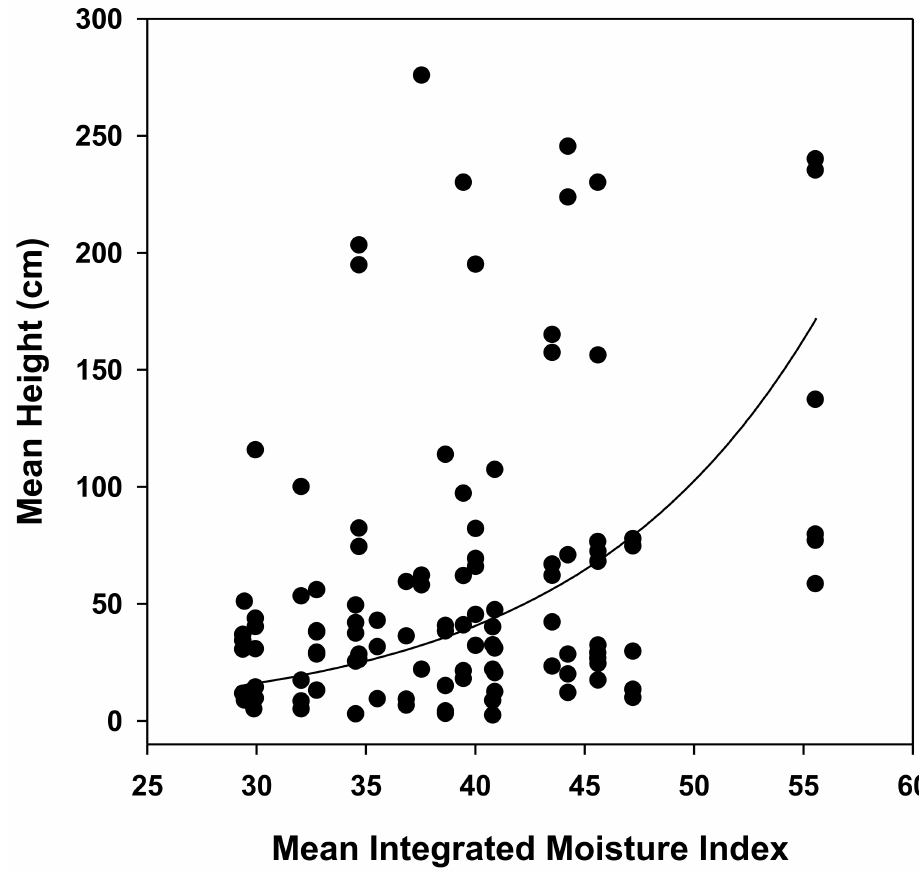
Figure 5. Logarithmic relationship between mean integrated moisture index (IMI; [32]) and birch seedling height (cm). Plot shows data for all sites and all